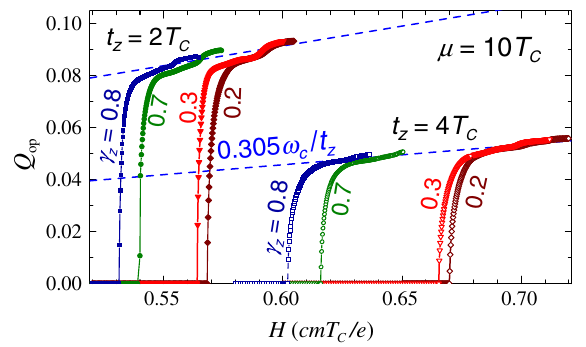
FIG. 4. The field dependences of the optimal modulation wave vector Q for μ ¼ 10 T , two values of t z C several values of the spin-splitting parameter γ values 0.25 and 0.75. The curves are marked by the values of γ The dashed lines show the expected low-temperature behavior, Eq.